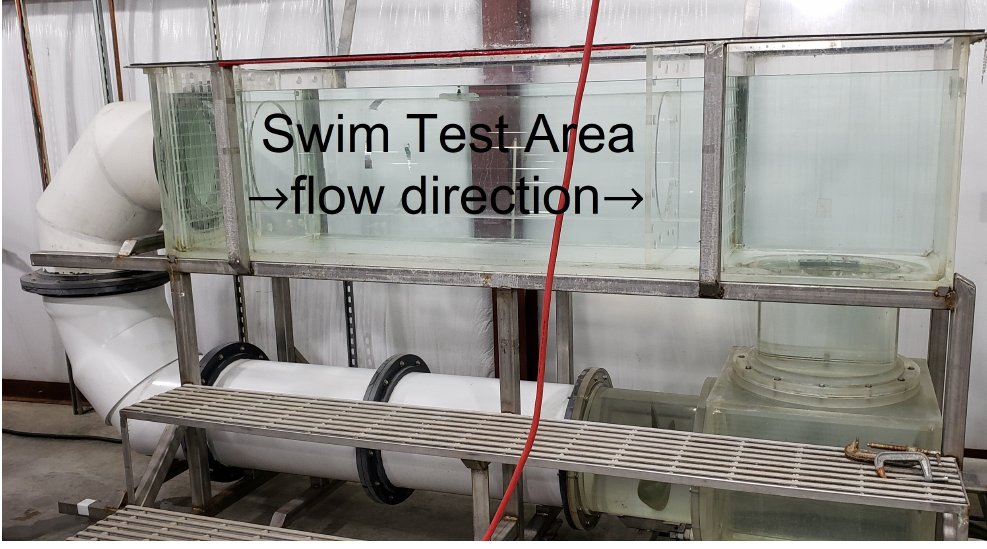
Figure 9. Brett-type swim tunnel used in proof-of-concept experiment. The orange power cord is visible in the